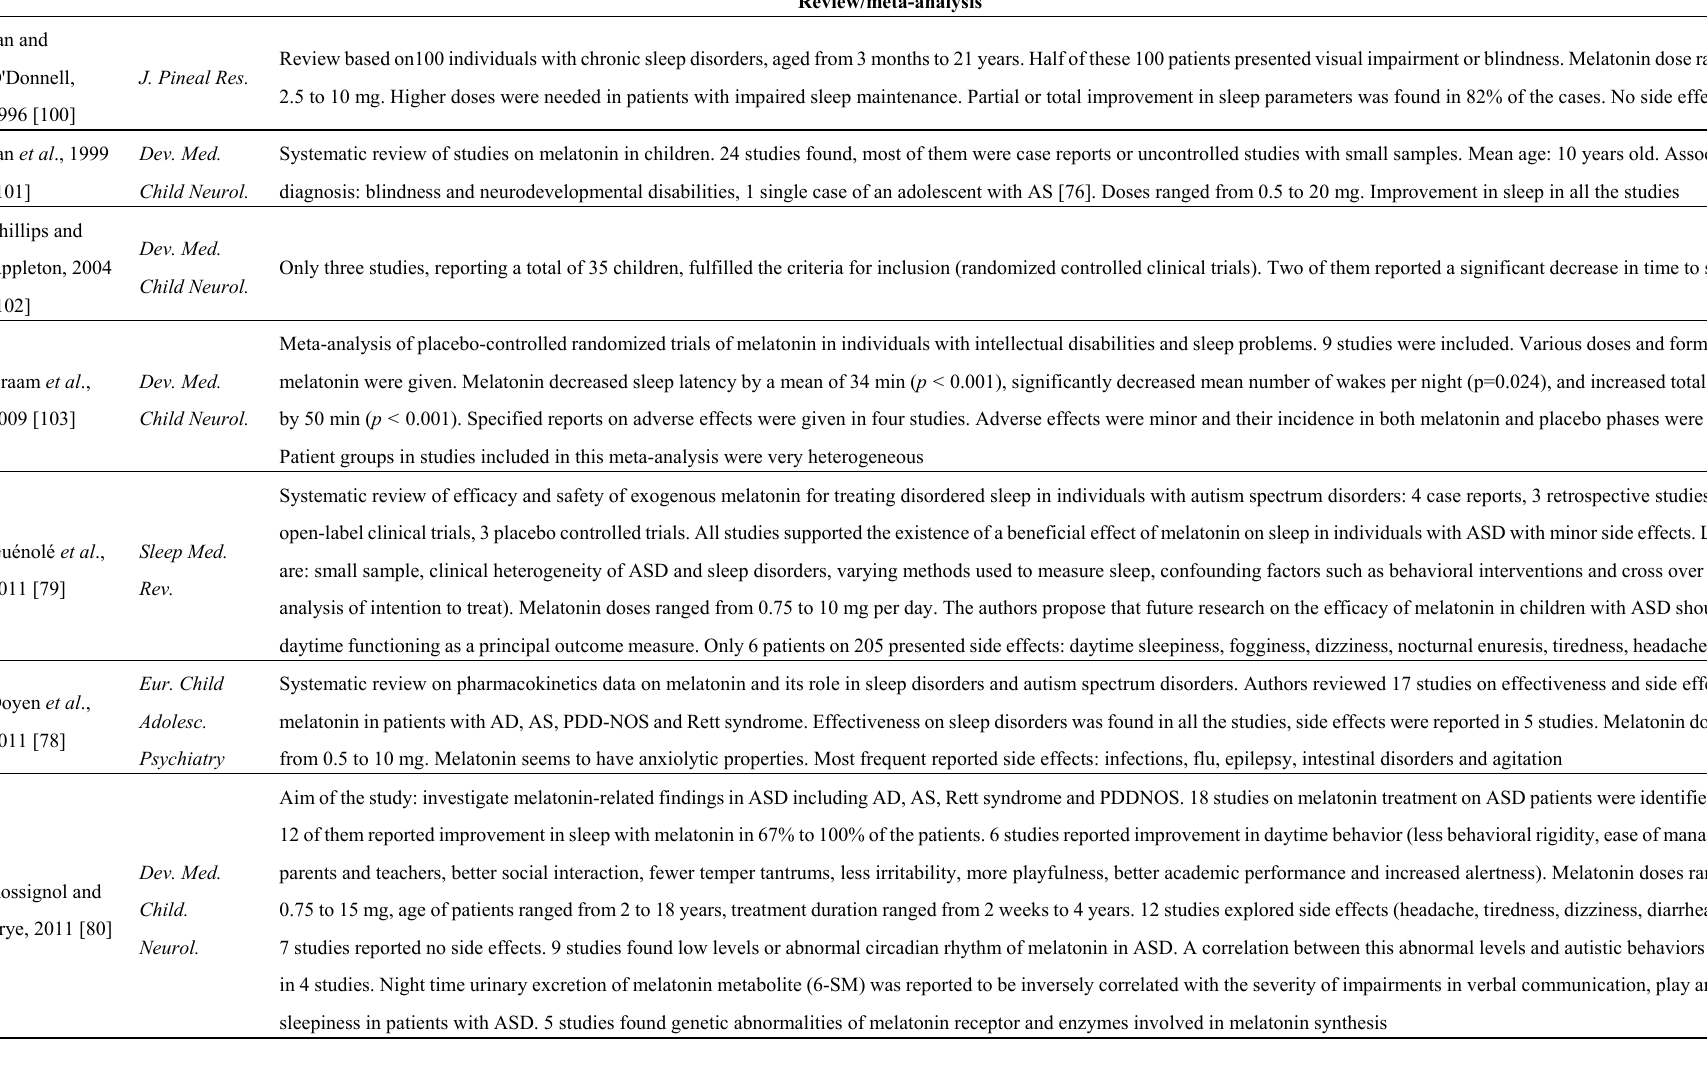
Table 3. Review, meta-analysis and discussion of therapeutic uses of melatonin in autistic disorder.